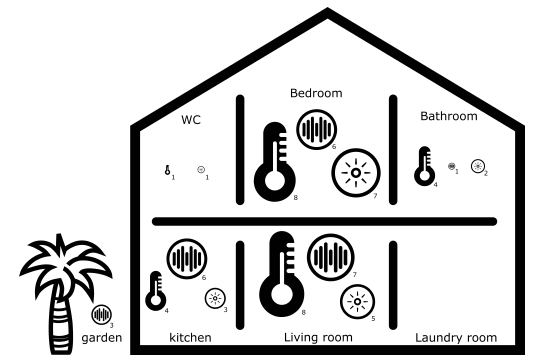
Figure 4. End users sensors locations preferences